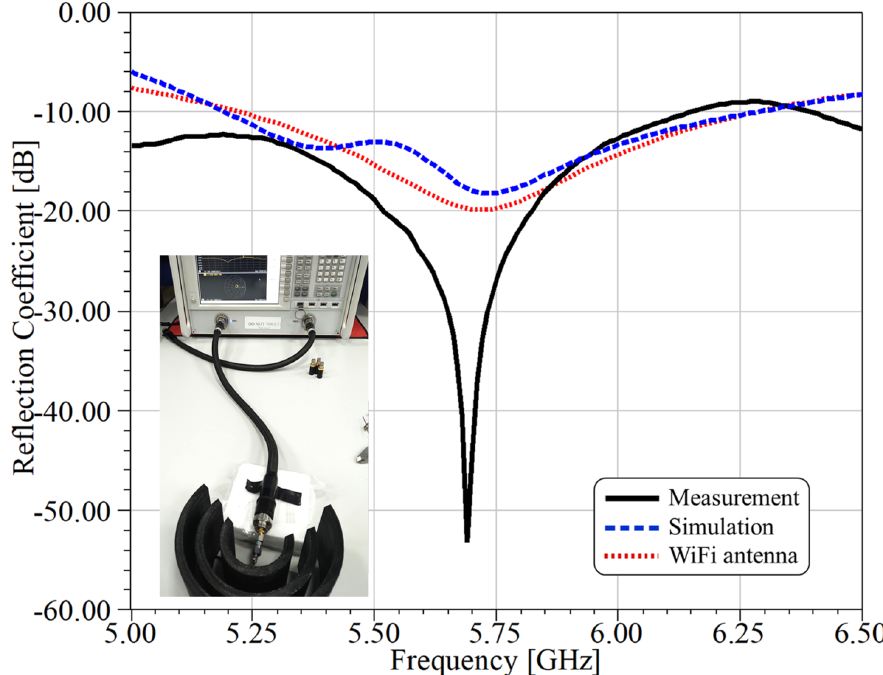
Figure 7. The experimental results for the S 11 parameter for the antenna with (solid–black curve) and without (blue-dashed line) the Bragg reflector. The red dotted curve corresponds to simulations for the antenna without the Bragg reflector.